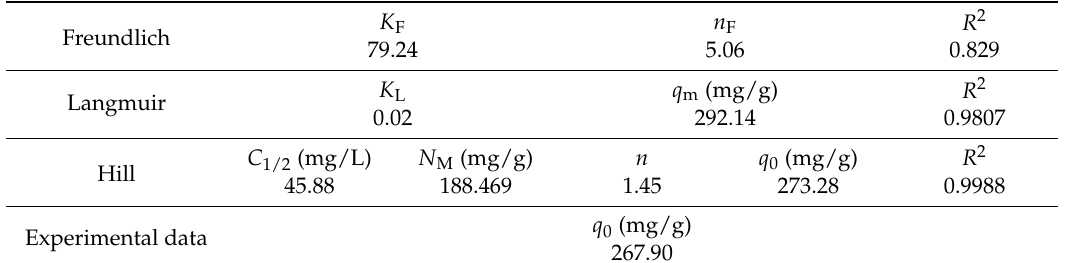
Table 4. Parameters of isotherm models on the adsorption of Pd(II) by AQ-PGMA.